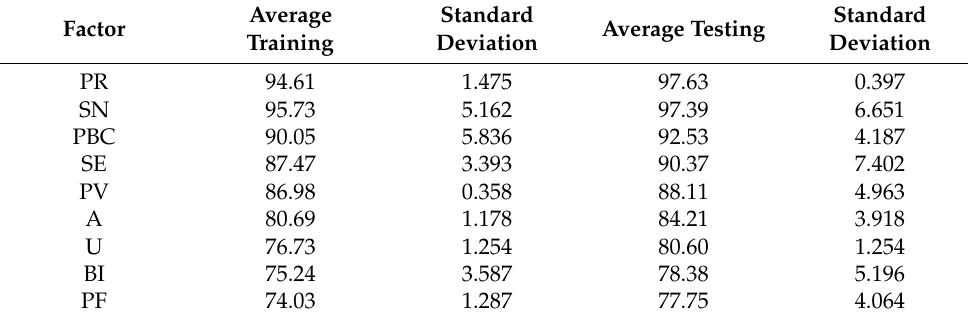
Table 6. Summarized Result for Deep Learning Neural